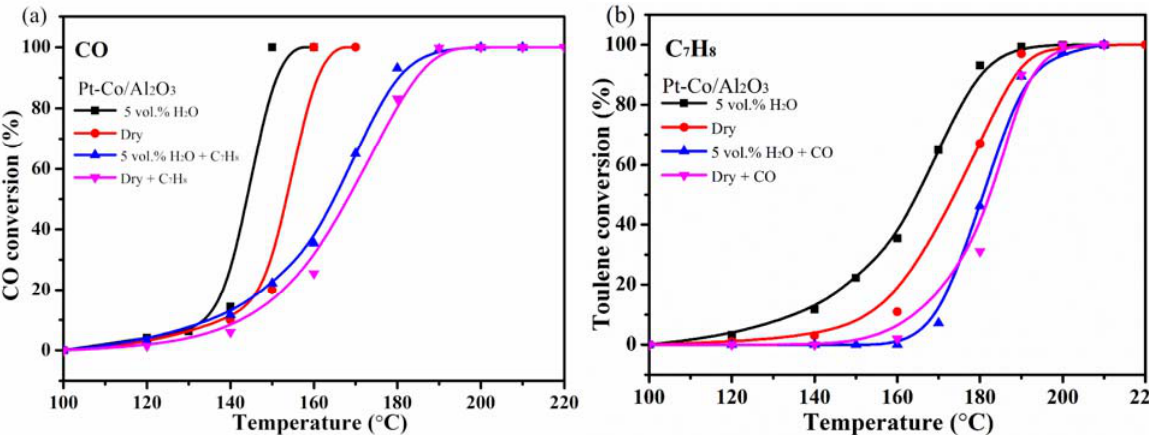
Figure 9. The effect of moisture on the ( a ) CO and ( b ) toluene conversions in different conditions over the Pt-Co/Al 2 O 3 catalyst with a weight hourly space velocity (WHSV) = 60,000 mL g − 1 h − 1 .